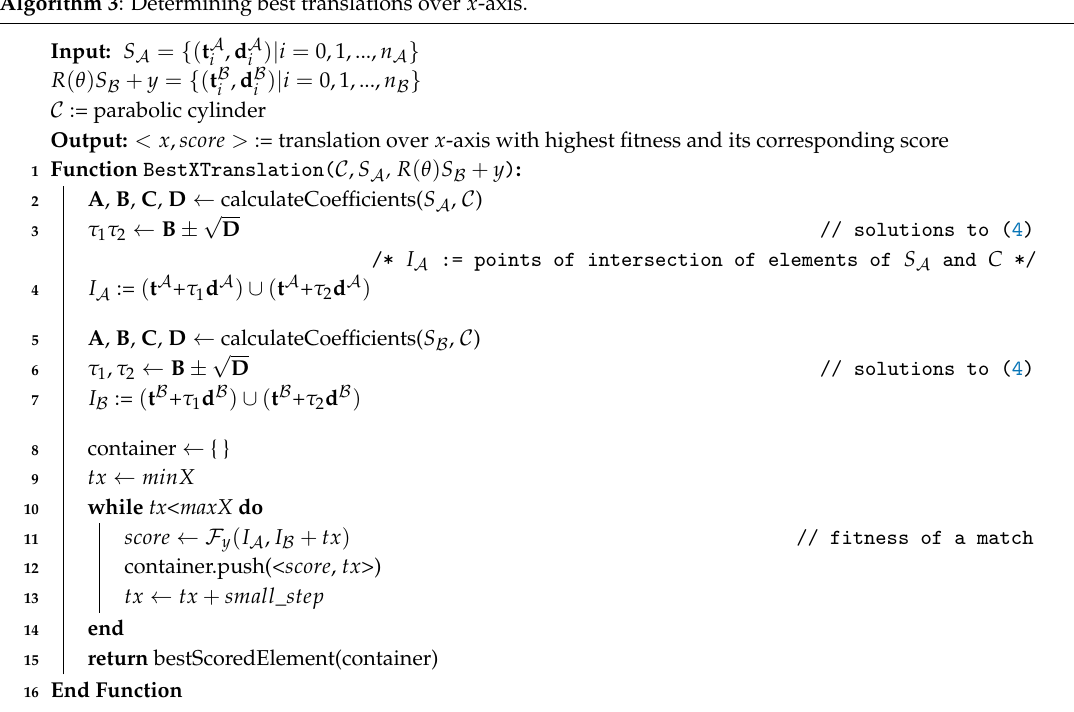
Algorithm 3 : Determining best translations over x